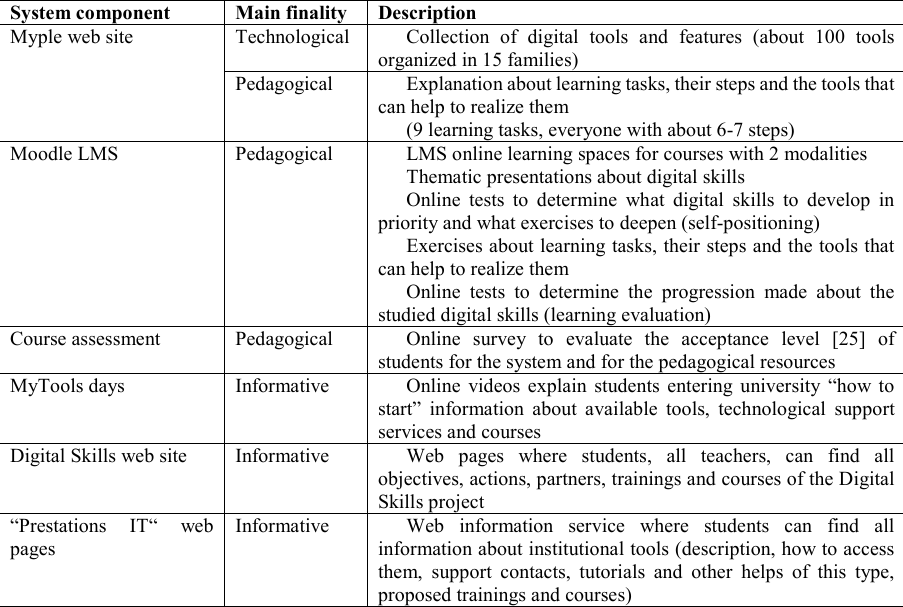
Table 1. Components of the courses’